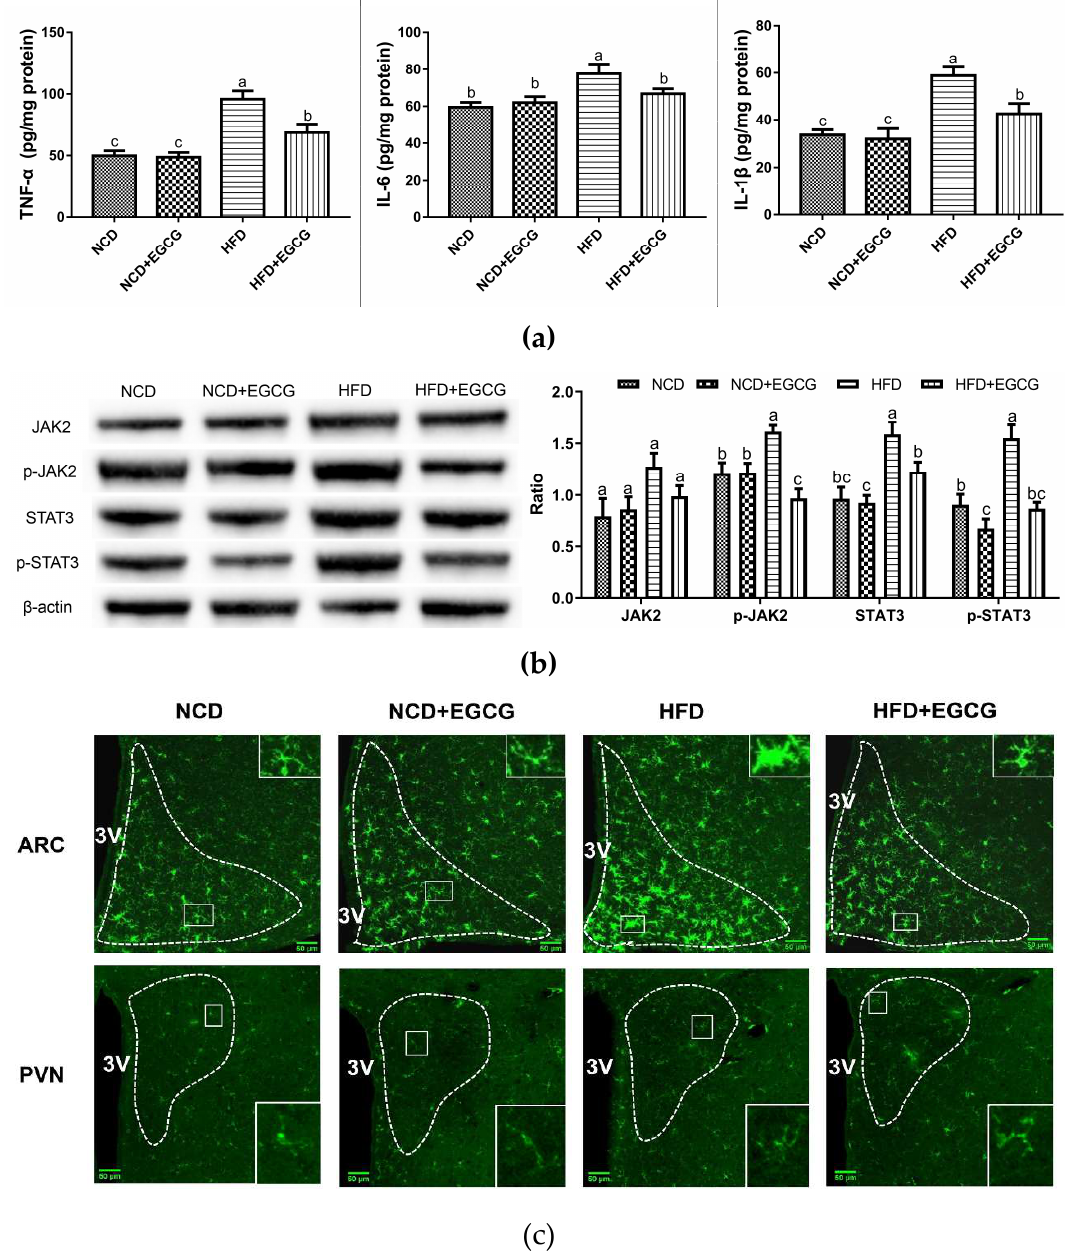
Figure 4. Inhibition effect of (−)-epigallocatechin gallate (EGCG) on obesity-associated neuroinflammation of hypothalamus. ( a ) Concentrations of TNF-α, IL-6, IL-1β in the hypothalamus; ( b ) Representative Western blots for JAK2 and STAT3 phosphorylation levels in the hypothalamus; ( c ) Representative micrographs of immunofluorescence labeling for Iba1 in the hypothalamic arcuate nucleus (ARC) and paraventricular nucleus (PVN) (outlined by white dashed lines) and higher magnification insets (outlined by white solid lines). Data are means ± SEM of three independent experiments performed in triplicate ( n = 3). Different superscript letters indicate significantly different means at p < 0.05 (a > b > c).